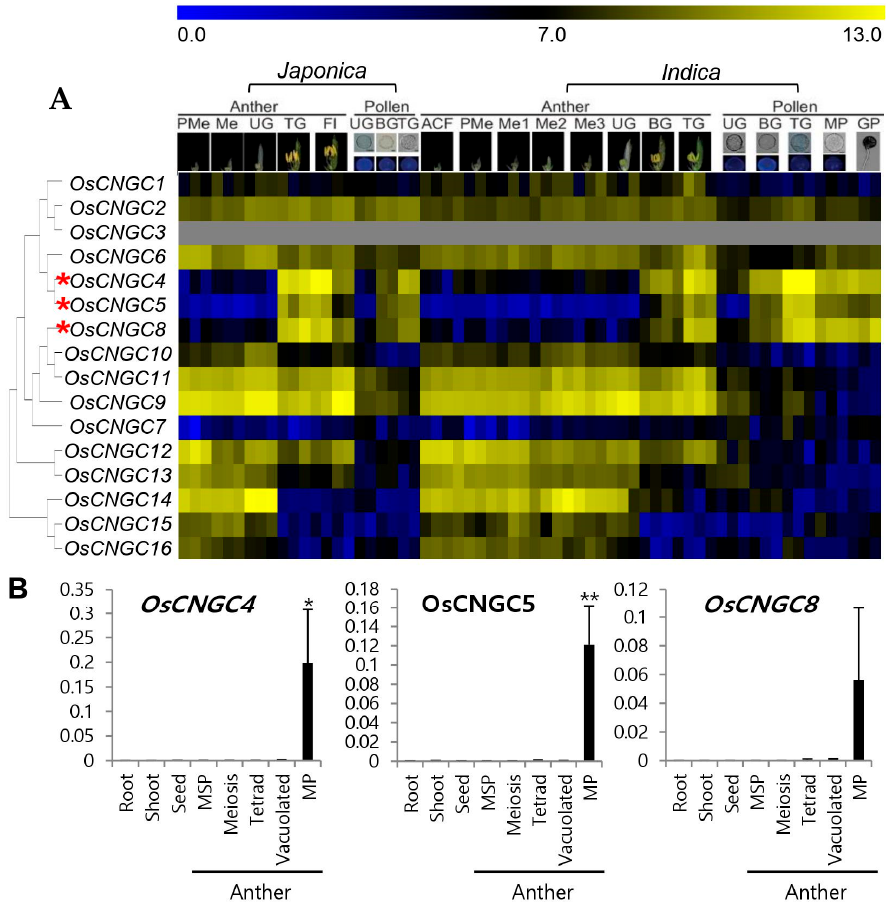
Figure 3. ( A ) Heatmap expression and phylogenetic analysis of 16 OsCNGC genes revealed three genes that were preferentially expressed in pollen. Yellow color in the heatmap indicates a high level of expression, whereas dark blue indicates low expression. Numeric values indicate an average of the normalized log2 intensity value of the microarray data. Pollen-preferentially expressed OsCNGC genes are indicated by red asterisks. ACF, archesporial cell-forming stage; BG, bicellular gametophyte stage; Fl, flowering stage; GP, germinated pollen; Me, meiotic stage; Me1, meiotic leptotene stage; Me2, meiotic zygotene-pachytene stage; Me3, meiotic diplotene-tetrad stage; MP, mature pollen stage; PMe, pre-meiosis; TG, tricellular pollen stage; UG, uni-cellular gametophyte stage. ( B ) Expression of pollen-preferred OsCNGC genes analyzed via qPCR in various tissues of rice. Msp, Microspore; MP, mature pollen. Rice ubiquitin 5 ( OsUbi5, LOC_Os01g22490 ) was used as an internal control. The y-axis shows the expression level relative to OsUbi5 , while the x-axis shows the samples used for analyses. Error bars represent the standard errors of three biological replicates. Significant differences are indicated by asterisks; * p < 0.01 and ** p < 0.0001. To verify the meta-expression patterns in the late pollen development stages, real- time (qPCR) analysis (Figure 3B) was performed. We used anther tissues at various devel- opmental stages containing meiosis microspores, tetrad microspores, young microspores, vacuolated pollen, and mature pollen, with other tissues, such as root, shoot, and seed. The results demonstrated that pollen-preferred OsCNGC genes had the highest expression at the later stages, but not in other tissues. These three genes were used for further studies.